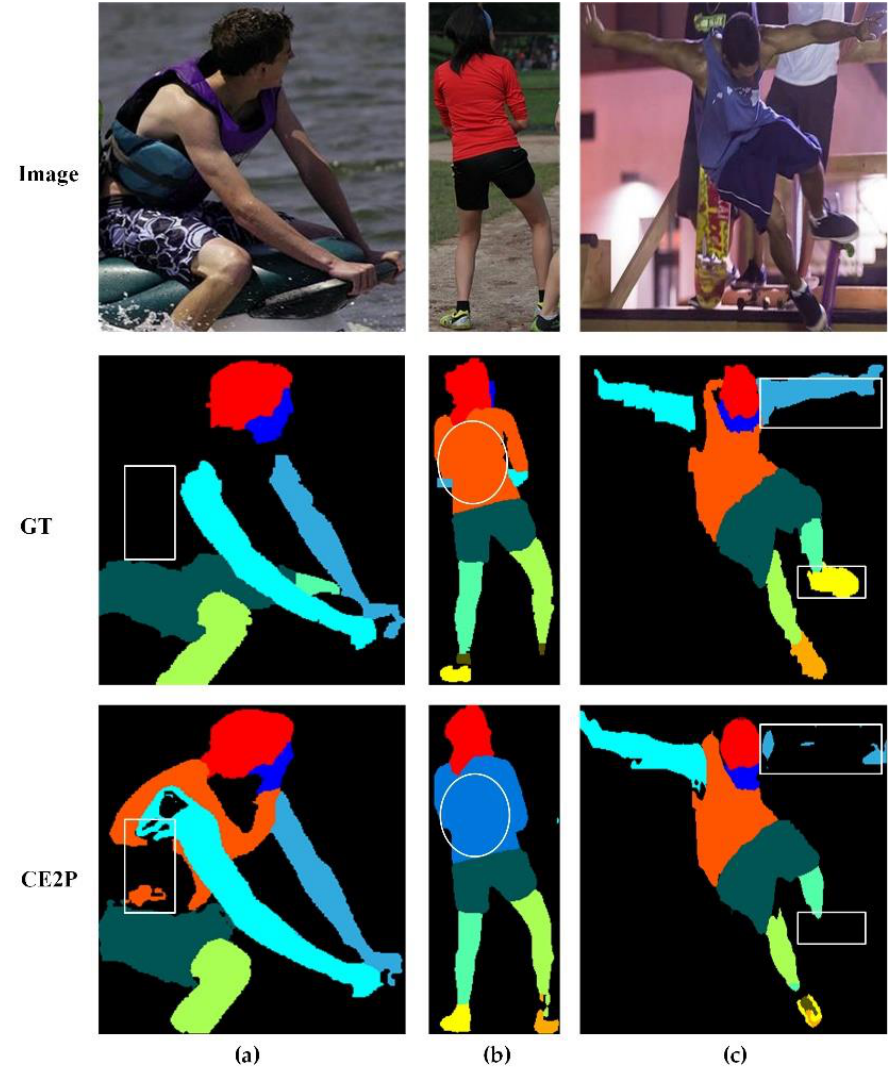
Figure 1. Illustration of unreliable human parsing results in CE2P [6]. ( a ) Inaccurate human body area recognition; ( b ) Similar appearances are confused; ( c ) Unidentified human information.